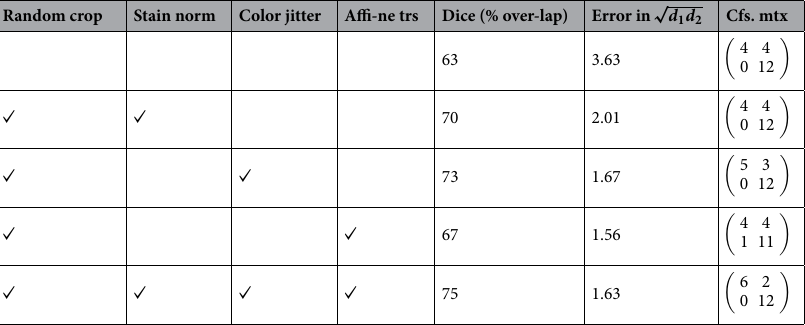
✓ ✓ Table 4. The effect of data augmentation on slide-level tasks using the K-means negative sampling strategy, 256 as the tile stride, and EfficientNet-B0 architecture.